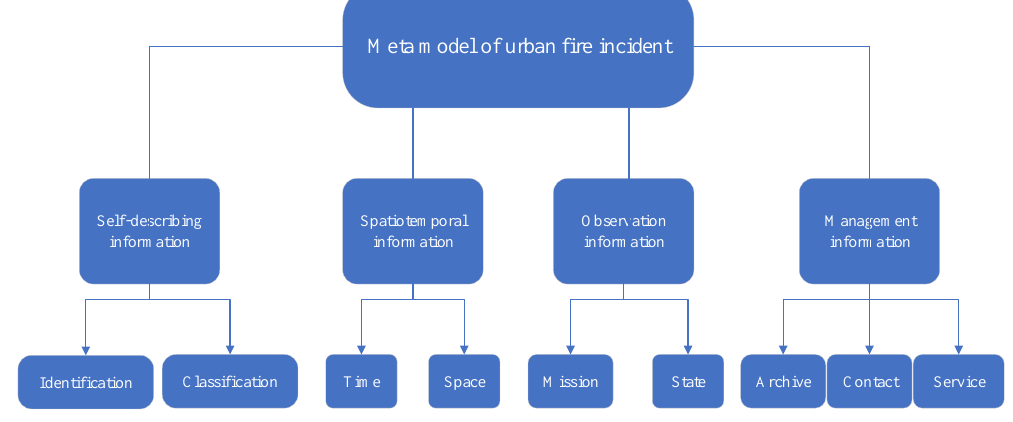
Figure 2. Meta model of urban fire